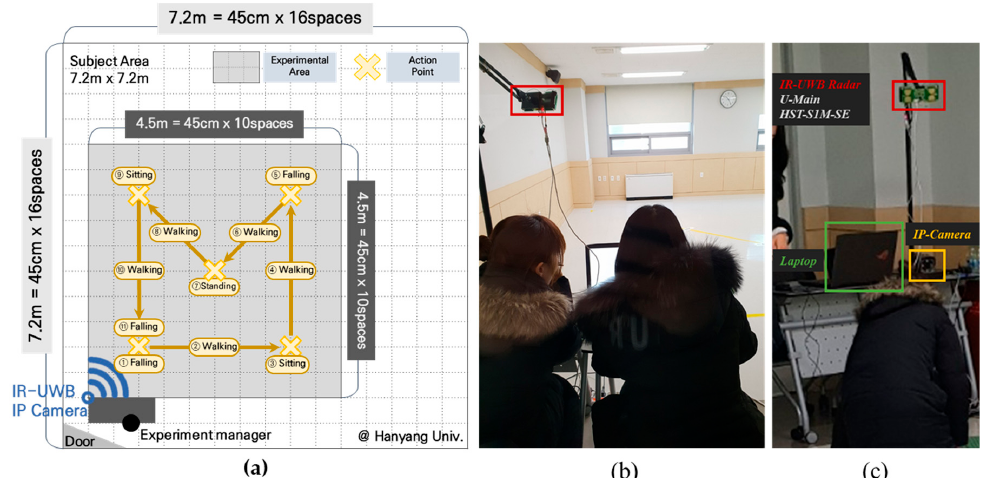
Figure 10. Informative diagram of data collection experimental environments: ( a ) sensor position, range of experimental area, action point, ( b ) the location of the test supervisor, ( c ) the location of the IR-UWB sensor, laptop, and IP camera.